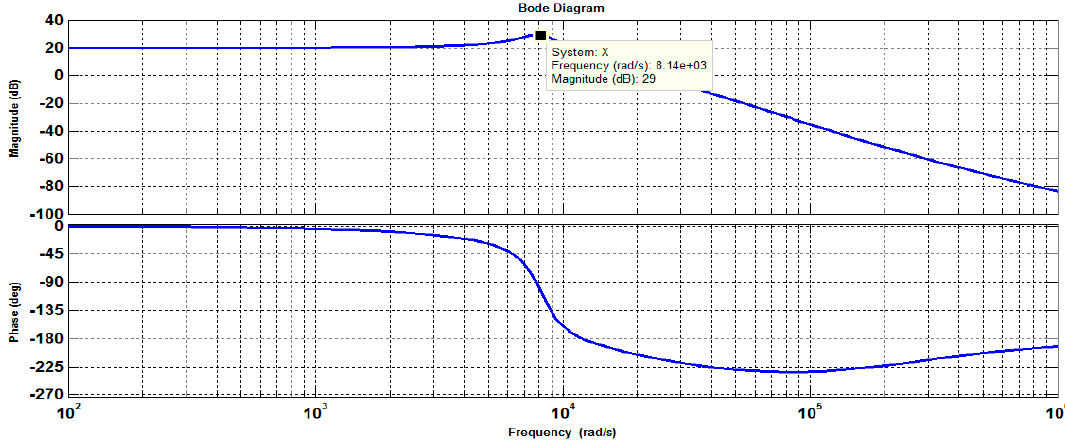
Figure 15. Bode plot for feedback current controller with LCL filter.